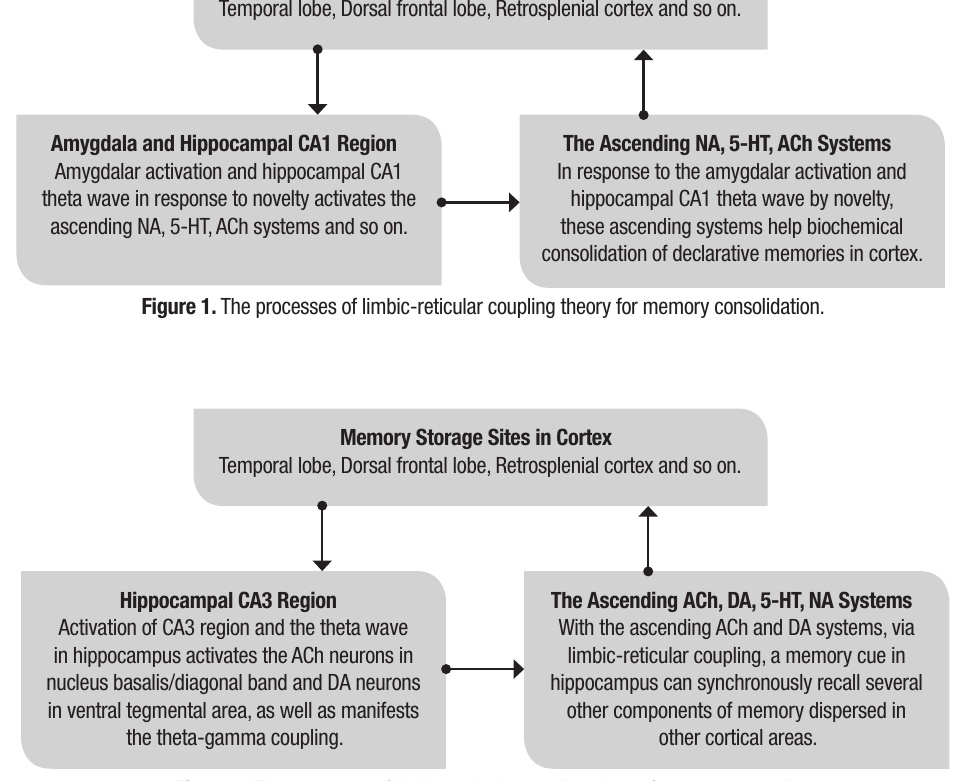
Figure 2. The processes of limbic-reticular coupling theory for memory